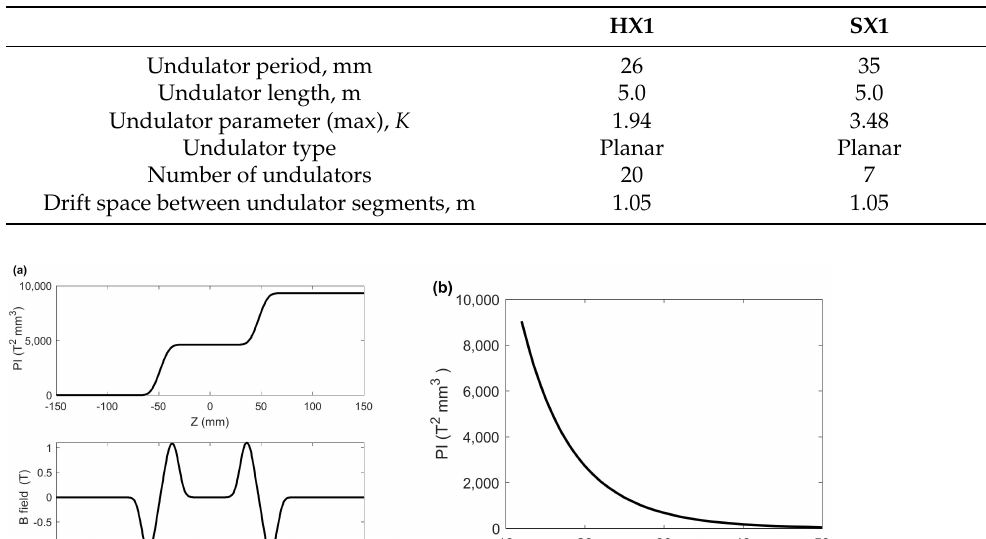
Table 1. Undulator parameter.